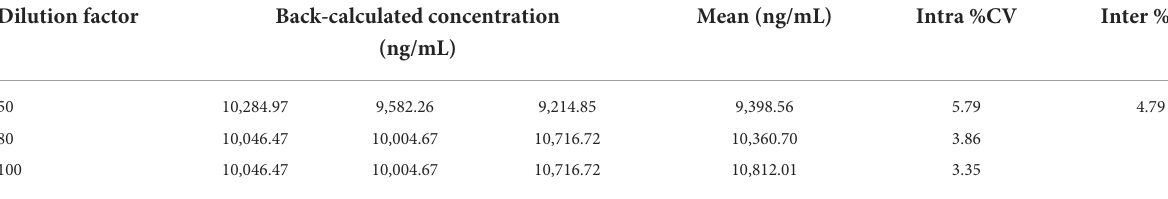
TABLE 3 Evaluation of parallelism of the recombinant canine PD-1 fusion protein determination in drug-free plasma with 3 different dilutions. Dilution factor Back-calculated concentration Mean (ng/mL) Intra %CV Inter %CV (ng/mL)